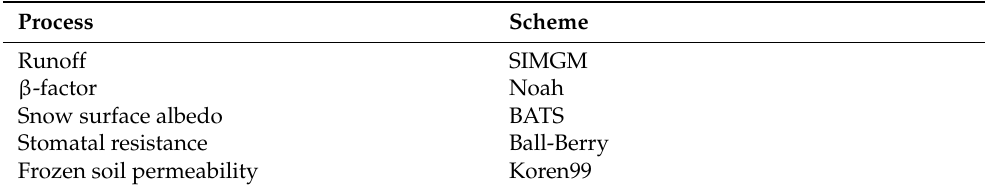
Table 2. Parameterization schemes for the key processes in the Noah-MP